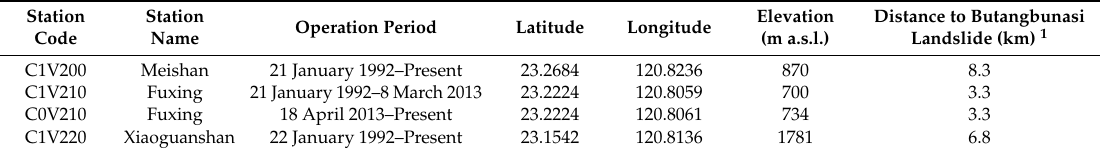
Table 3. Selected Central Weather Bureau (CWB) rain gauge stations.